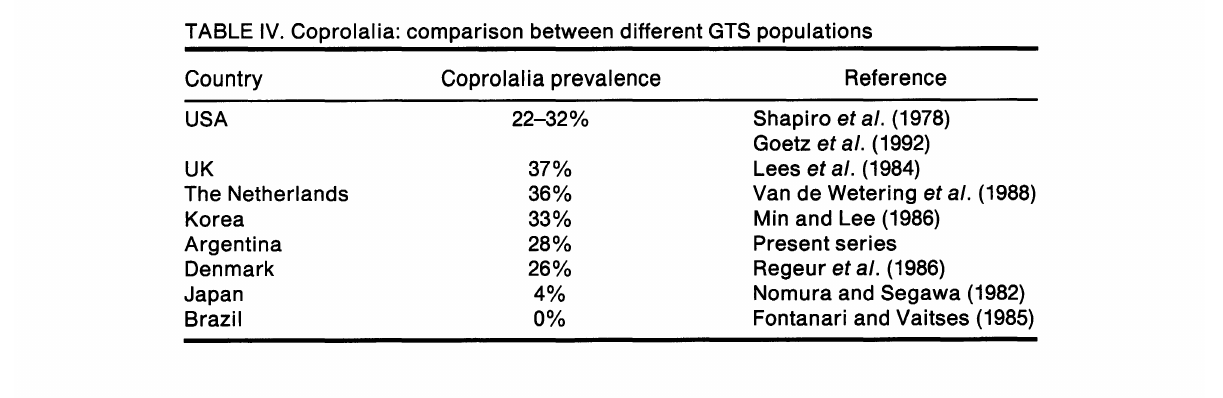
TABLE IV. Coprolalia: comparison between different GTS